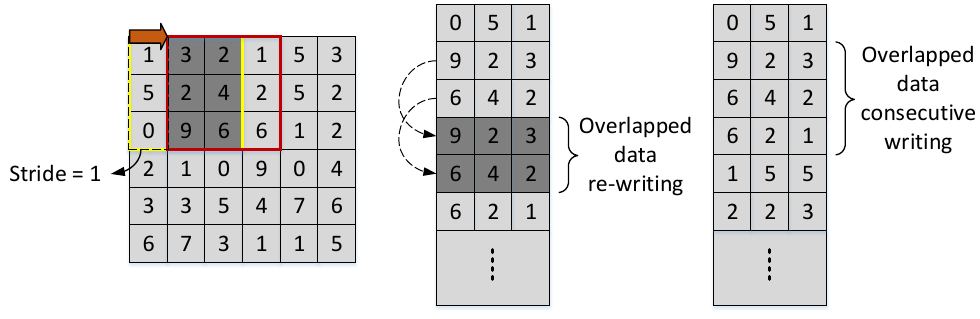
Figure 8. Proposed data arrangement